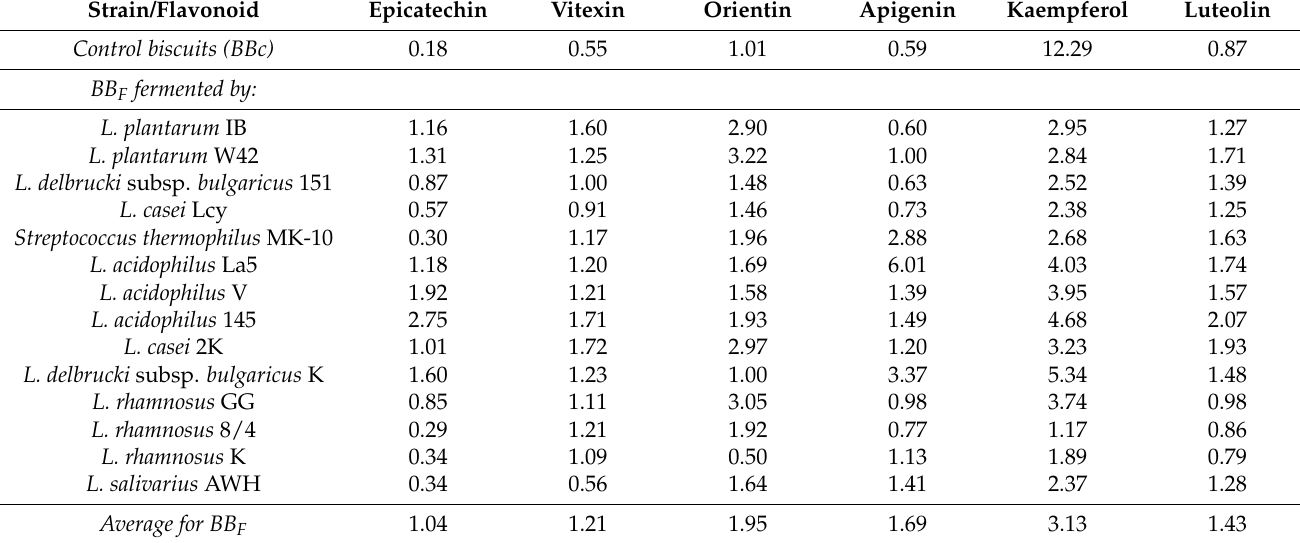
Table 6. Bioaccessibility indexes (BI) of flavonoids from buckwheat biscuits prepared from unfer- mented (BB C ) and fermented (BB F ) flours by selected lactic acid